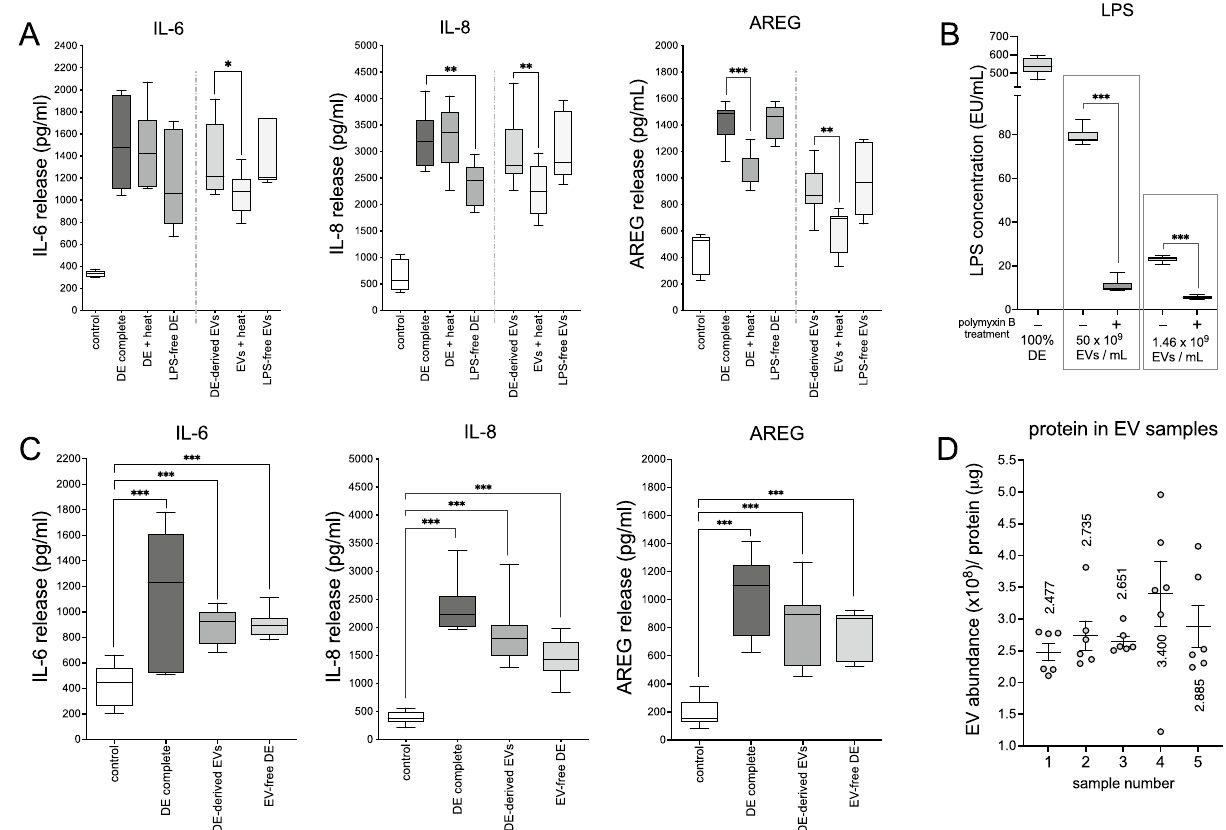
Figure 4. Stimulatory effects of EVs are sensitive to heating but are not due to LPS contamination and the effects of complete DE are partially due to the EV cargo. Saturated (100%) DE was subjected to heat (90 °C for 15 min) or LPS ablation (polymyxin B, 12 h @ 4 °C). HBEC were challenged with EVs isolated from these preparations (5% DE equivalents) or with heat-or polymyxin B-treated 5% DE for 24 h ( A ).